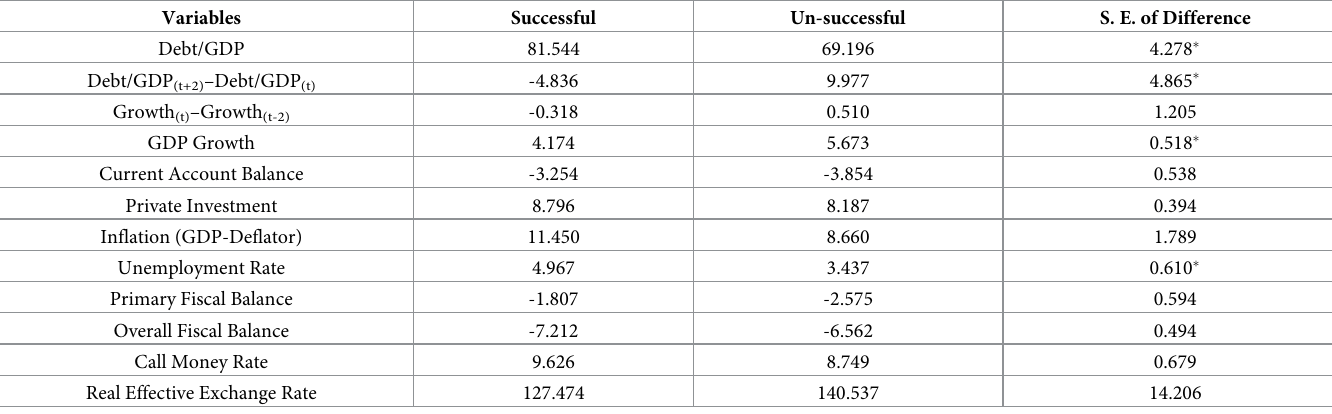
Table 3. Macroeconomic variables during successful and un-successful episodes. Variables